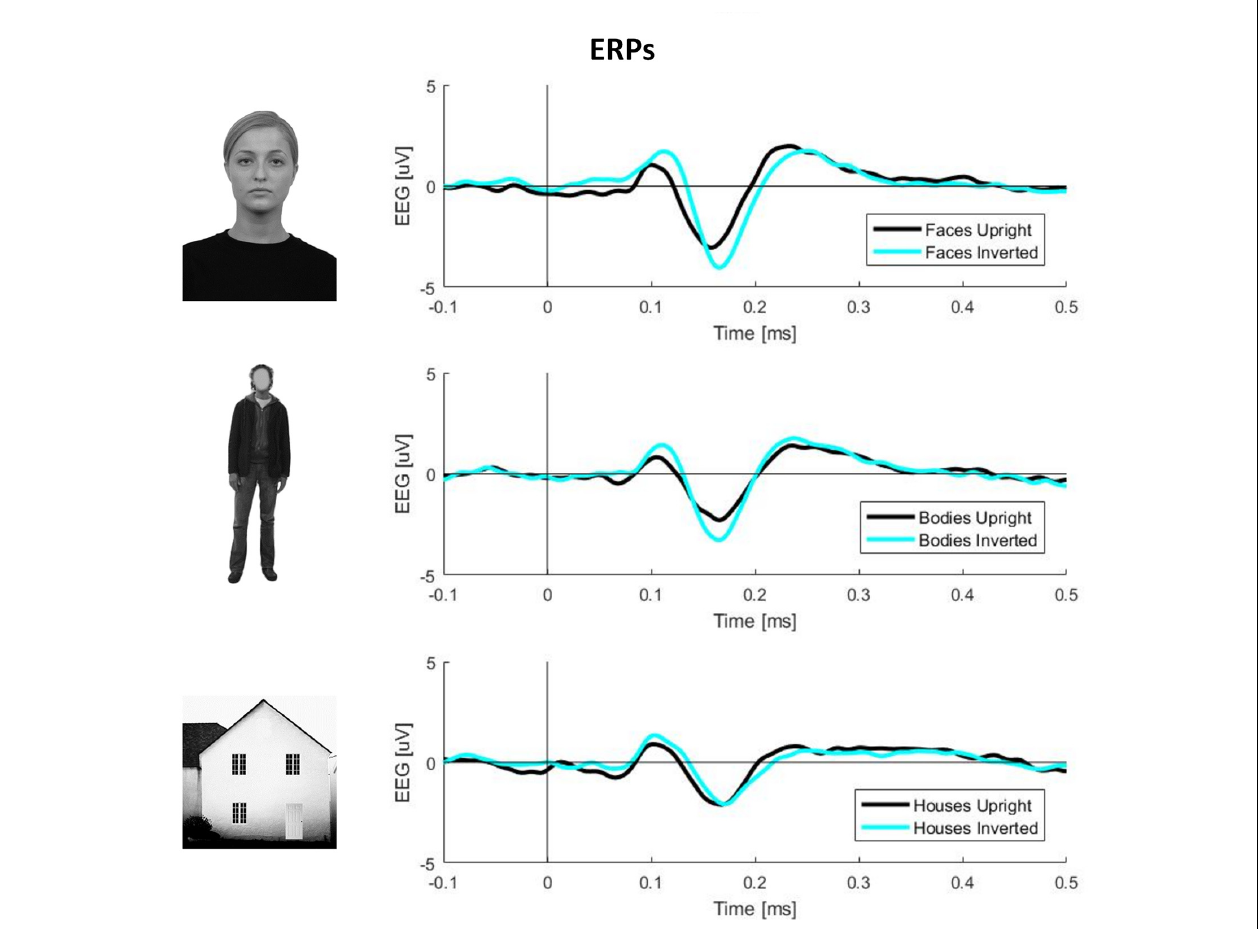
FIGURE 1 | Plots of event-related potential (ERP) activity calculated over 11 right occipito-temporal electrodes, averaged over 23 participants separately for three stimulus categories (faces, bodies, and houses). In each plot, the black line represents upright stimuli, while the cyan line represents inverted stimuli. This picture clearly shows larger N170 components (negative deflections around 170 ms post-stimulus onset) for inverted faces and bodies but not houses.